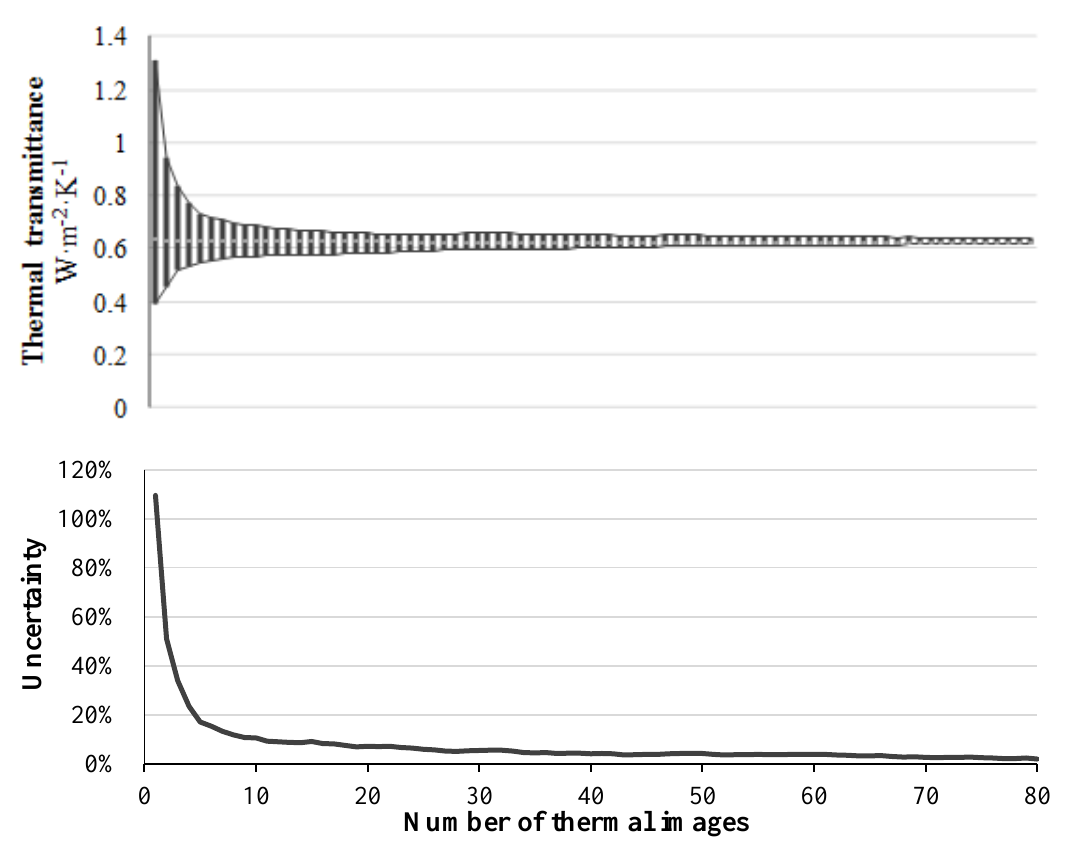
Figure 9. The span of values of thermal transmittance (upper figure) and the uncertainty in values of thermal transmittance (lower figure) vs. the number of measurements (thermal images).